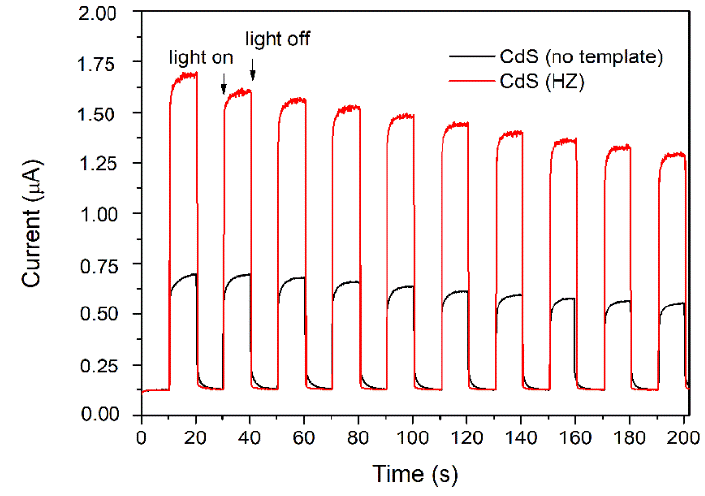
Figure 5. Photocurrent–time responses of CdS(HZ) and CdS prepared without template (350W Xe lamp as light source, in 0.2 M Na 2 SO 4 solution).